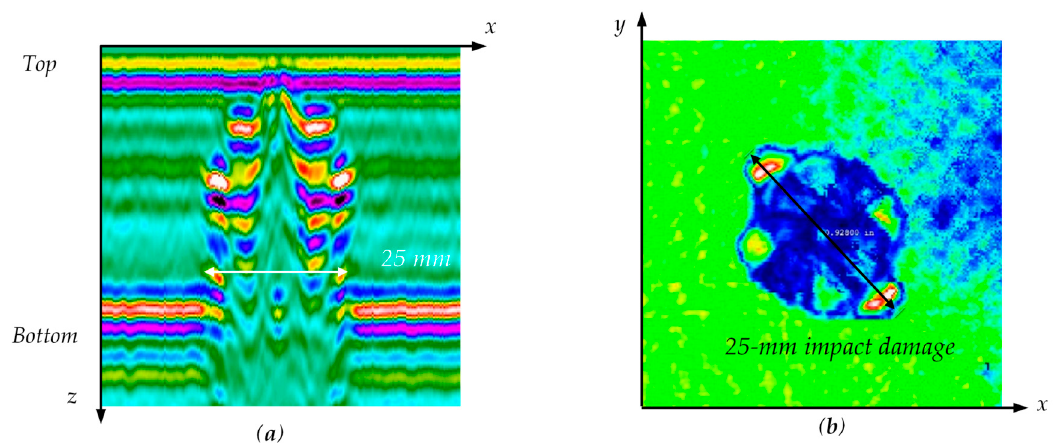
Figure 7. Ultrasonic NDT inspection results of the impact damage in the 2-mm quasi-isotropic composite coupon: ( a ) B-scan image; ( b ) C-scan image.